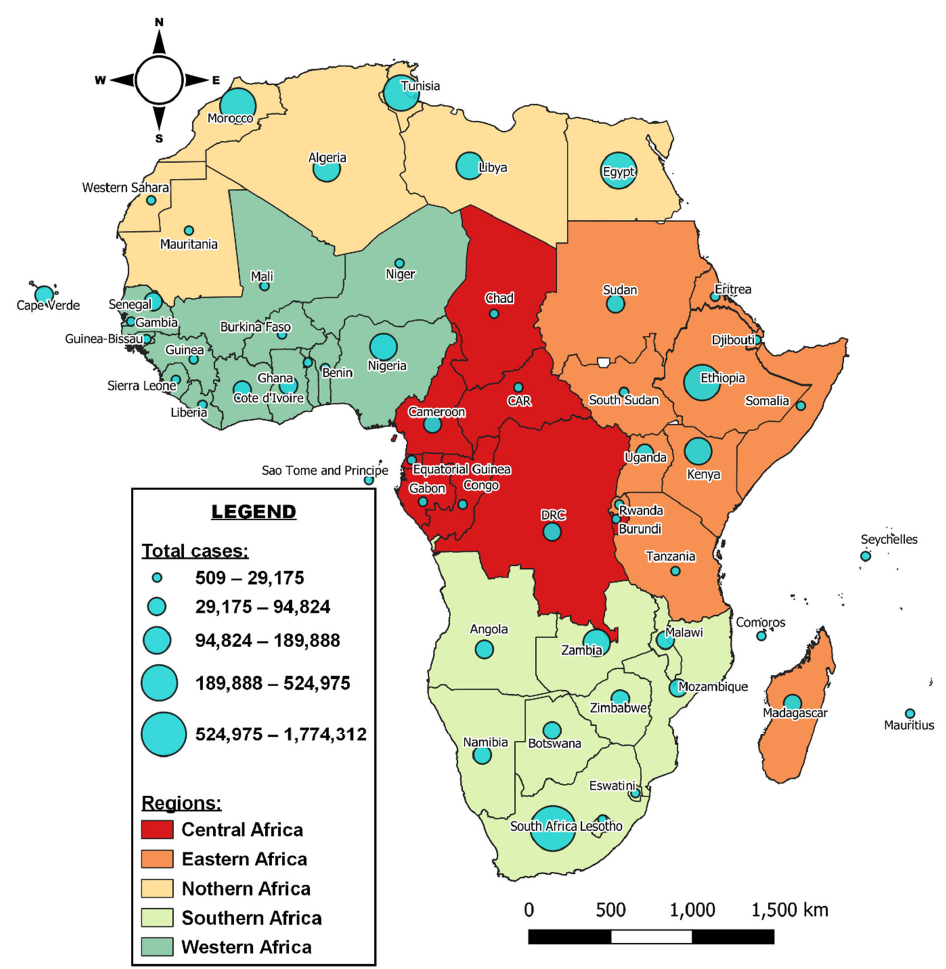
Figure 3. Overview of COVID-19 in Africa based on AU regions and Africa CDC data of 21 June 2021. Data source: https://africacdc.org/covid ‐ 19/ (accessed on 22 June 2021).